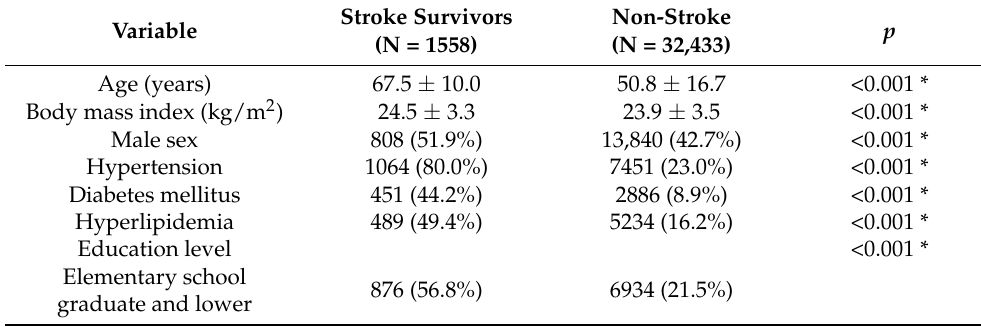
Table 1. Demographic and clinical characteristics of the study